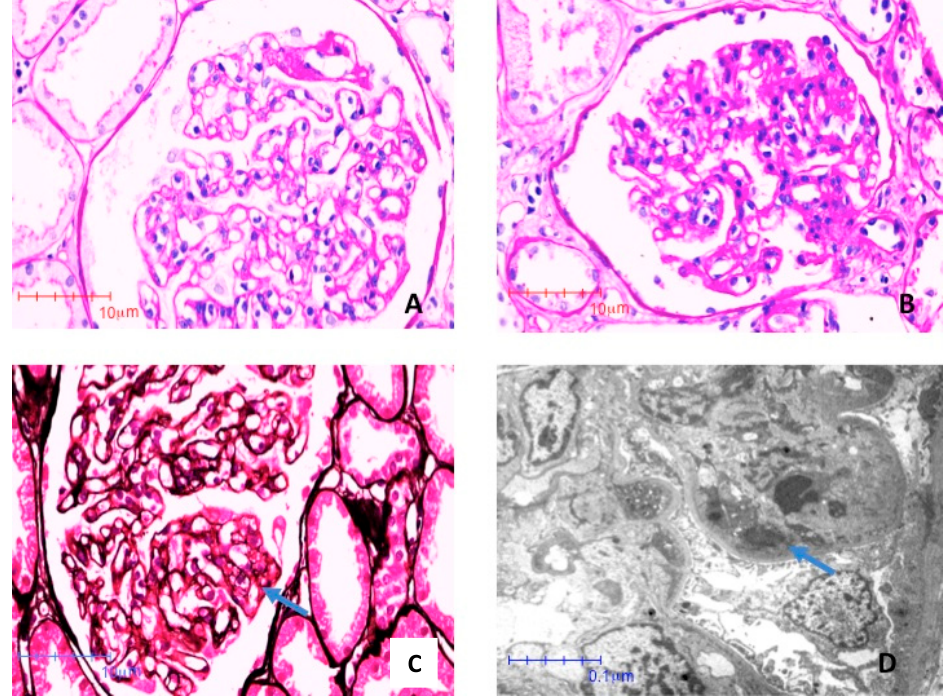
Figure 3. Photomicrographies stained with Periodic Acid Shiff (PAS) ( A ) and ( B ) and Jones Metenamine ( C ), respectively (40 × ). The glomeruli showed segments of mesangial proliferation and endocapillar hypercellularity. Edematous endothelial cells occlude some segments (arrow). ( D ) Electron photomicroscopy (8000 × ). Subendothelial electron dense deposits (immune complexes) are indicated by arrows.